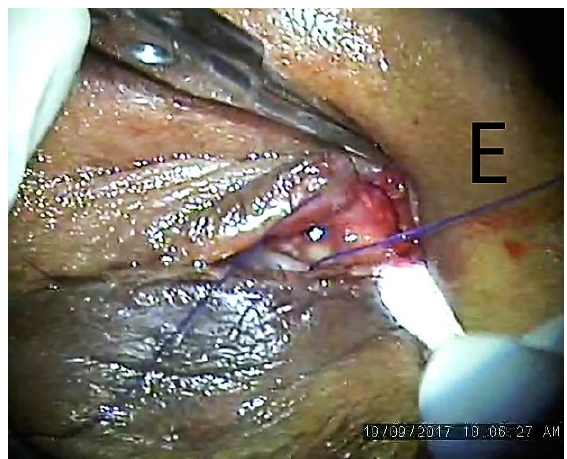
Figure 2: Blunt prolene needle passed through upper punctum